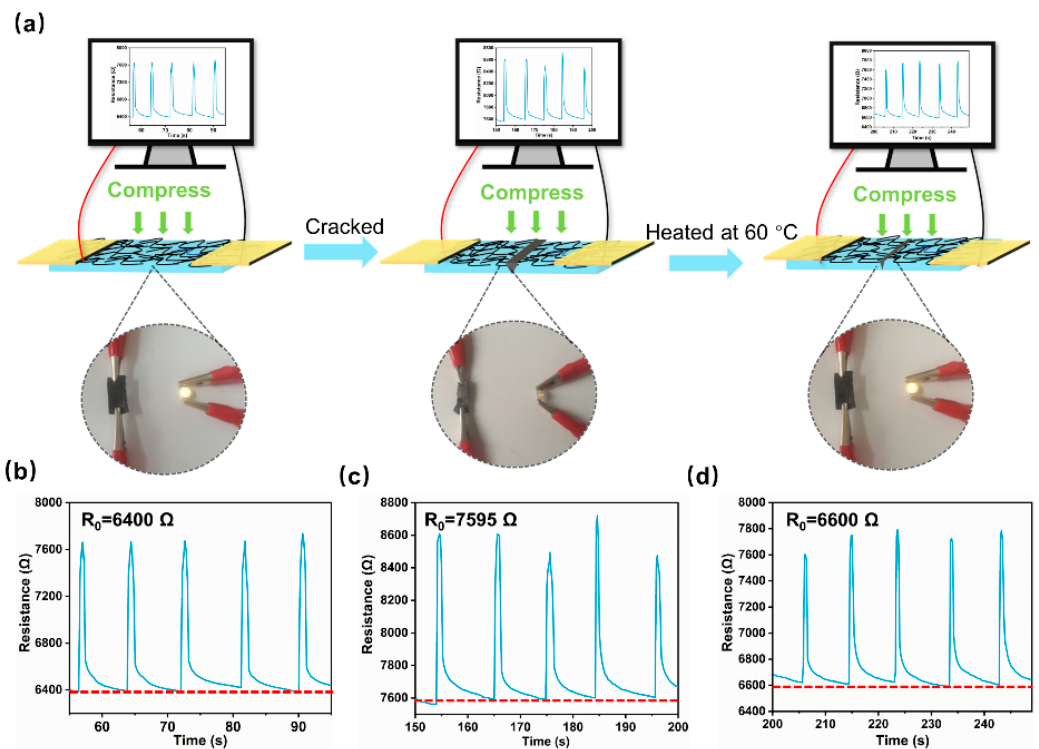
Figure 10. ( a ) Variations in resistance of SFPUHE-HTF-CNTs-3 at the states of being original, damaged, and healed (( b – d ) are their enlarged views, respectively); the physical diagrams show the brightness of a bulb when the SFPUHE-HTF-CNTs were connected to the circuit. The resistive sensing signals of SFPUHE-HTF-CNTs-3: ( b ) original; ( c ) damaged; ( d ) healed.